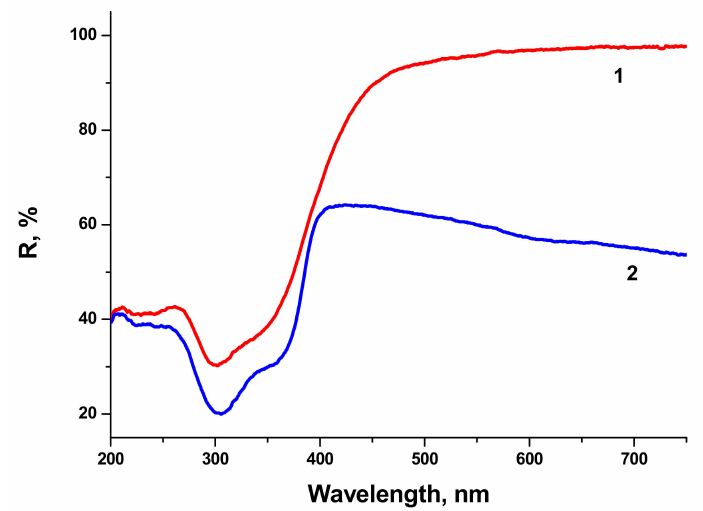
Figure 4. Reflectivity spectra of BTO NPs evaporated on alumina plate with respect to alumina ceramics. Ablation in H 2 O 2 (1), ablation in H 2 O (2). Yb fiber laser, pulse duration of 200 ns.